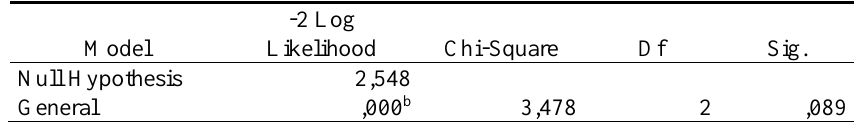
Table 10. Paralell Lines Test Result Test of Parallel Lines a